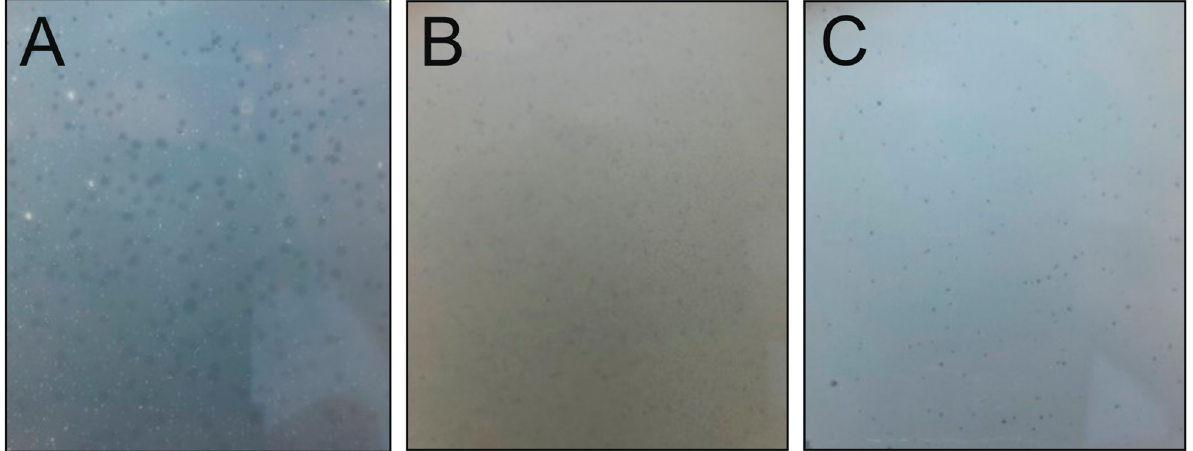
Figure 3. Plaque morphologies of ( A ) Lumi phage, ( B ) Kuura phage, and ( C ) Tiera phage grown on 1/5 LB at room temperature.